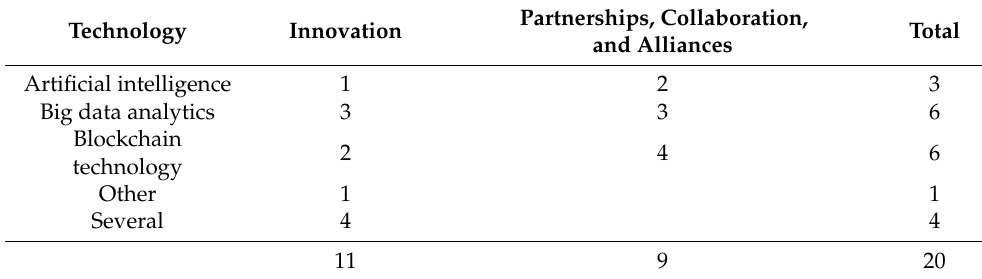
Table 3. Approaches to open